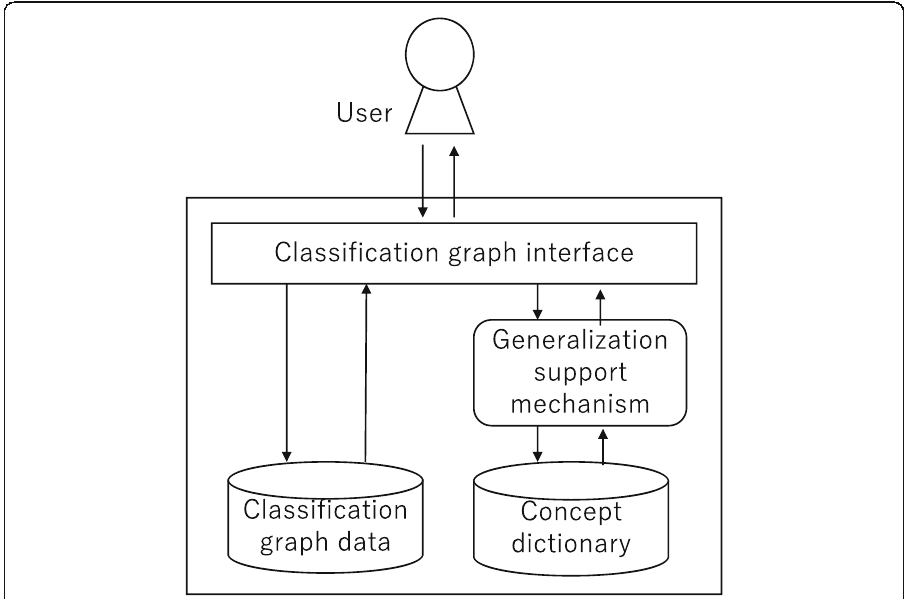
Fig. 2 Overall framework of